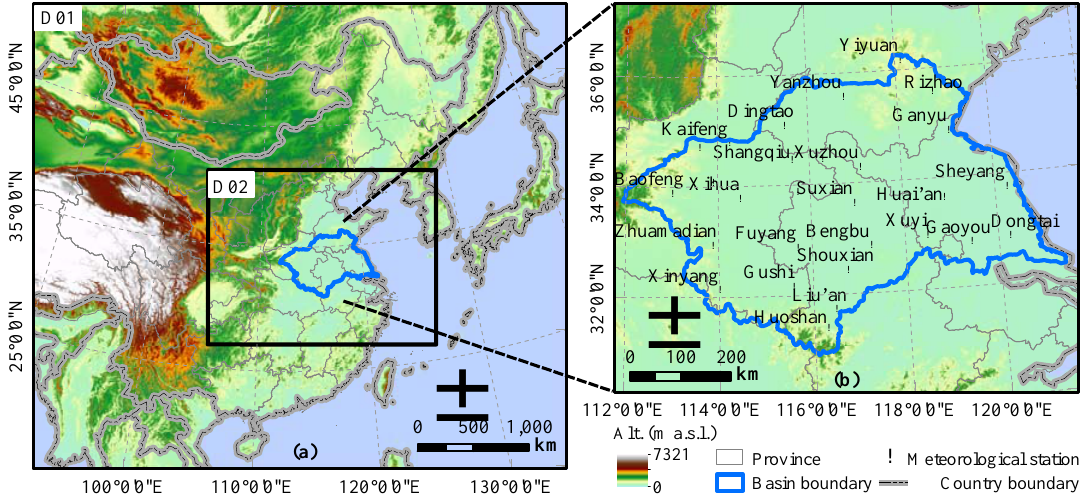
Figure 1. ( a ) Outer domain (D01, 27-km resolution) and inner domain (D02, 9-km resolution) defined in the Weather Research and Forecasting (WRF) model; ( b ) location and meteorological stations of the Huaihe River basin.